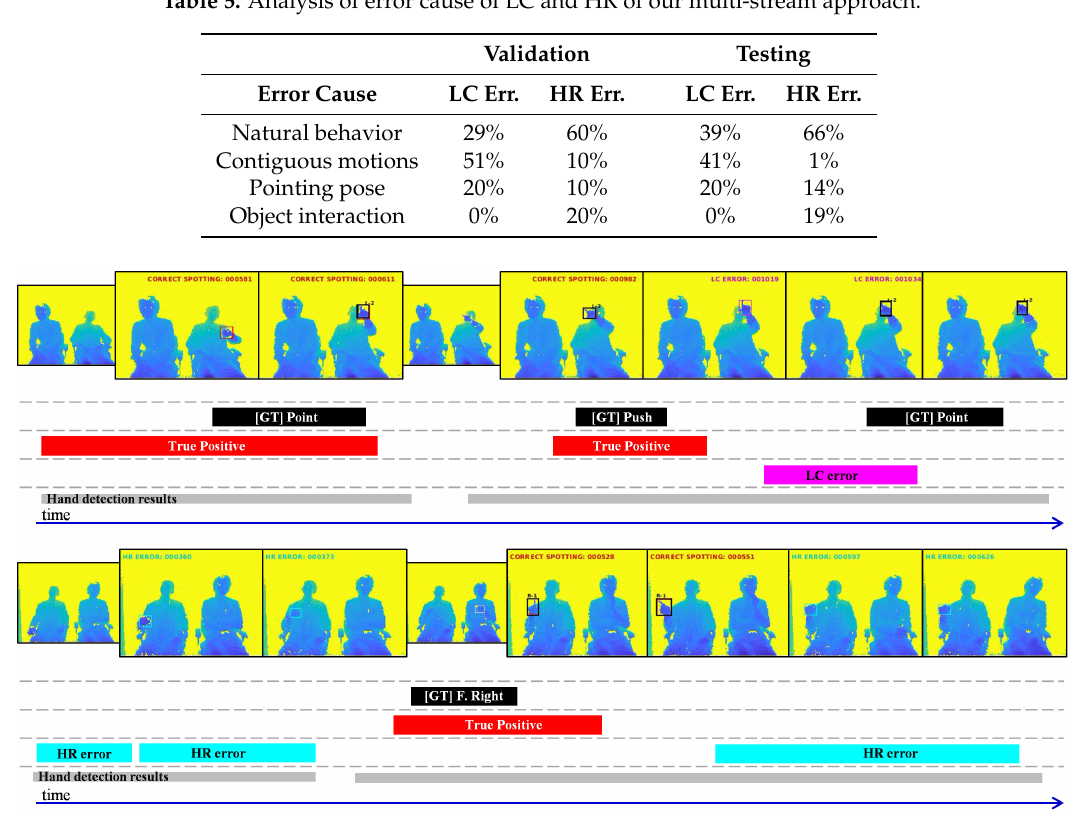
Figure 13. Qualitative results of our multi-stream approach. ( top ) A video sequence including pointing and pushing gestures. ( bottom ) A video sequence including a flicking-right gesture. The color-coded bars show the temporal location of the ground-truth and predictions (true-positives and false-positive), as well as the continuous hand detections achieved by module